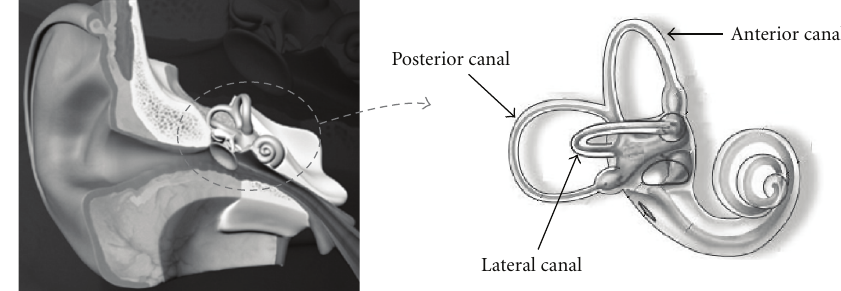
Figure 2: Global visualization of the inner ear and zoom on the 3 canals (angular sensors).